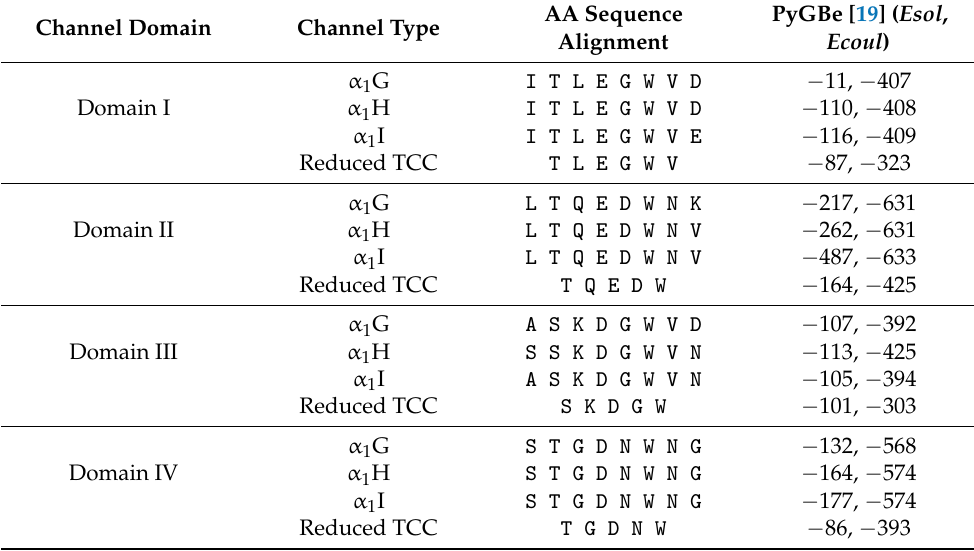
Table 1. Comparison of numerical results of P-loop electrostatic potential at the four different domains with different lengths of amino acid sequences. TCC: T-type calcium channel. Channel